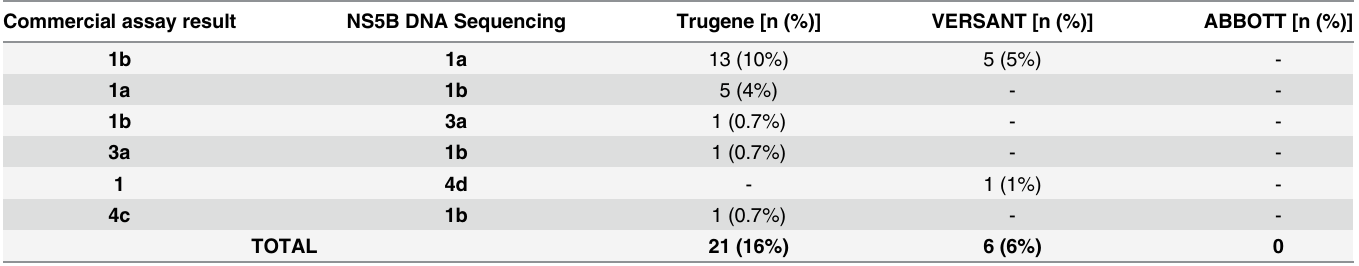
Table 2. Major discordances (differences in the assigned genotype by a commercial method and NS5B sequencing, including the misclassifica- tion of subtypes 1a and 1b) from the three assayed commercial tests compared to NS5B DNA sequencing. Commercial assay